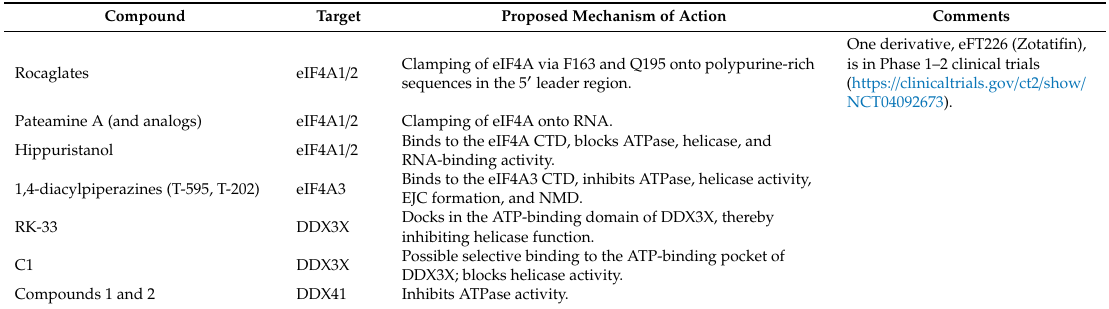
Table 2. Current Selective Inhibitors of DDX / DHX Family Members Implicated in Translation. Compound Target Proposed Mechanism of Action Comments Rocaglates eIF4A1 /